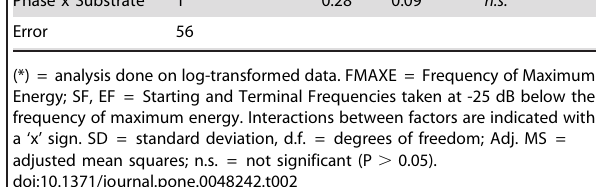
Table 2. Descriptive statistics and results of General Linear Model (GLM) Analysis of Variance for echolocation calls of approach and terminal phases recorded from B. barbastellus approaching water or Perspex.